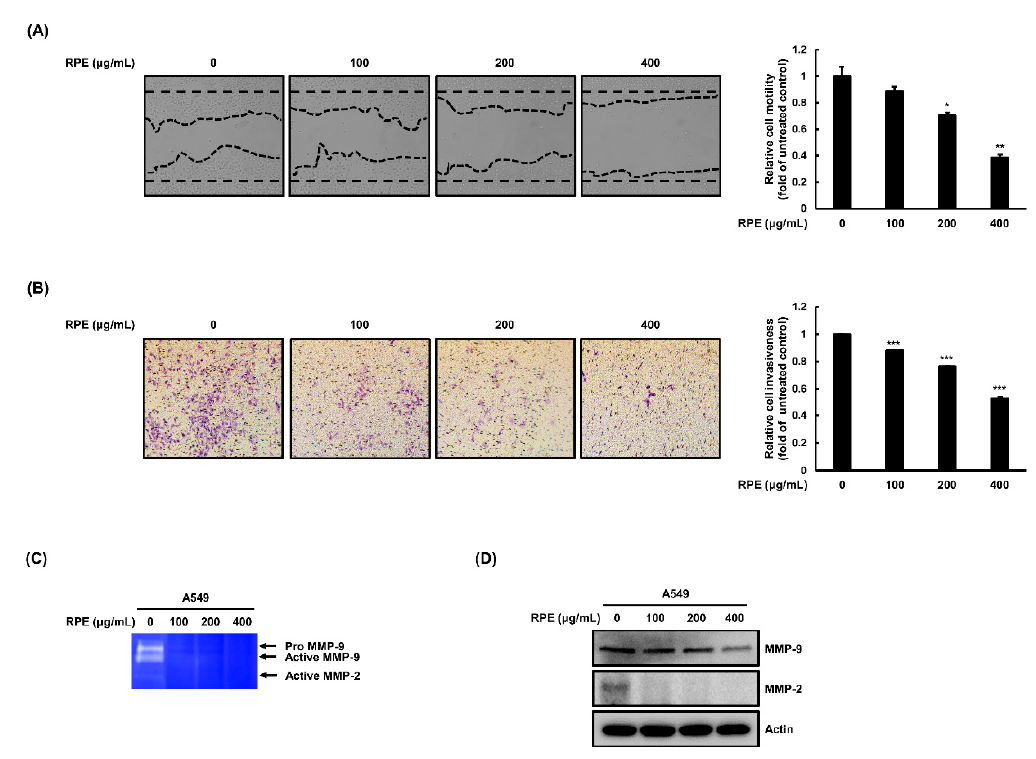
Figure 3. RPE reduces migration and invasion of human adenocarcinoma A549 cells. ( A ) Scratched A549 cells were treated with RPE for 24 h, and then the wound healing area was photographed and measured with the Image J program. ( B ) The cells that invaded through the extracellular matrix-like membrane were measured with the Matrigel invasion assay. Relative motility or invasiveness of cells is represented as means ± standard deviation ( n = 3) as * p < 0.05, ** p < 0.01, *** p < 0.005, compared with untreated group. Size of the scale bar in the images refer to 100 µ m. ( C ) Activities of matrix metalloproteinase-2 (MMP-2) and matrix metalloproteinase-9 (MMP-9) were detected by zymography and ( D ) expression of those were measured with Western blotting analysis. Representative bands are indicated.